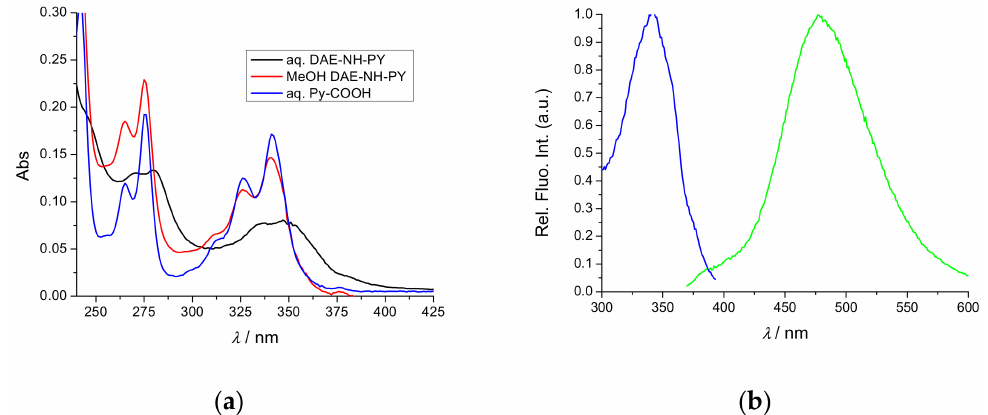
Figure 1. ( a ) UV/Vis spectra of DAE-NH-Py( c = 5.0 × 10 − 6 M) in MeOH ( – ) and in aqueous